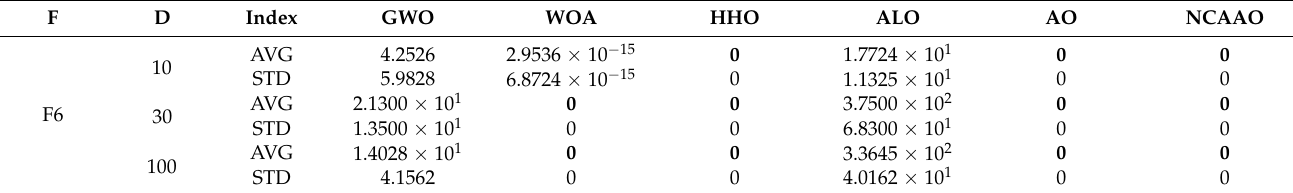
Table 6. The comparison of obtained solutions for multimodal